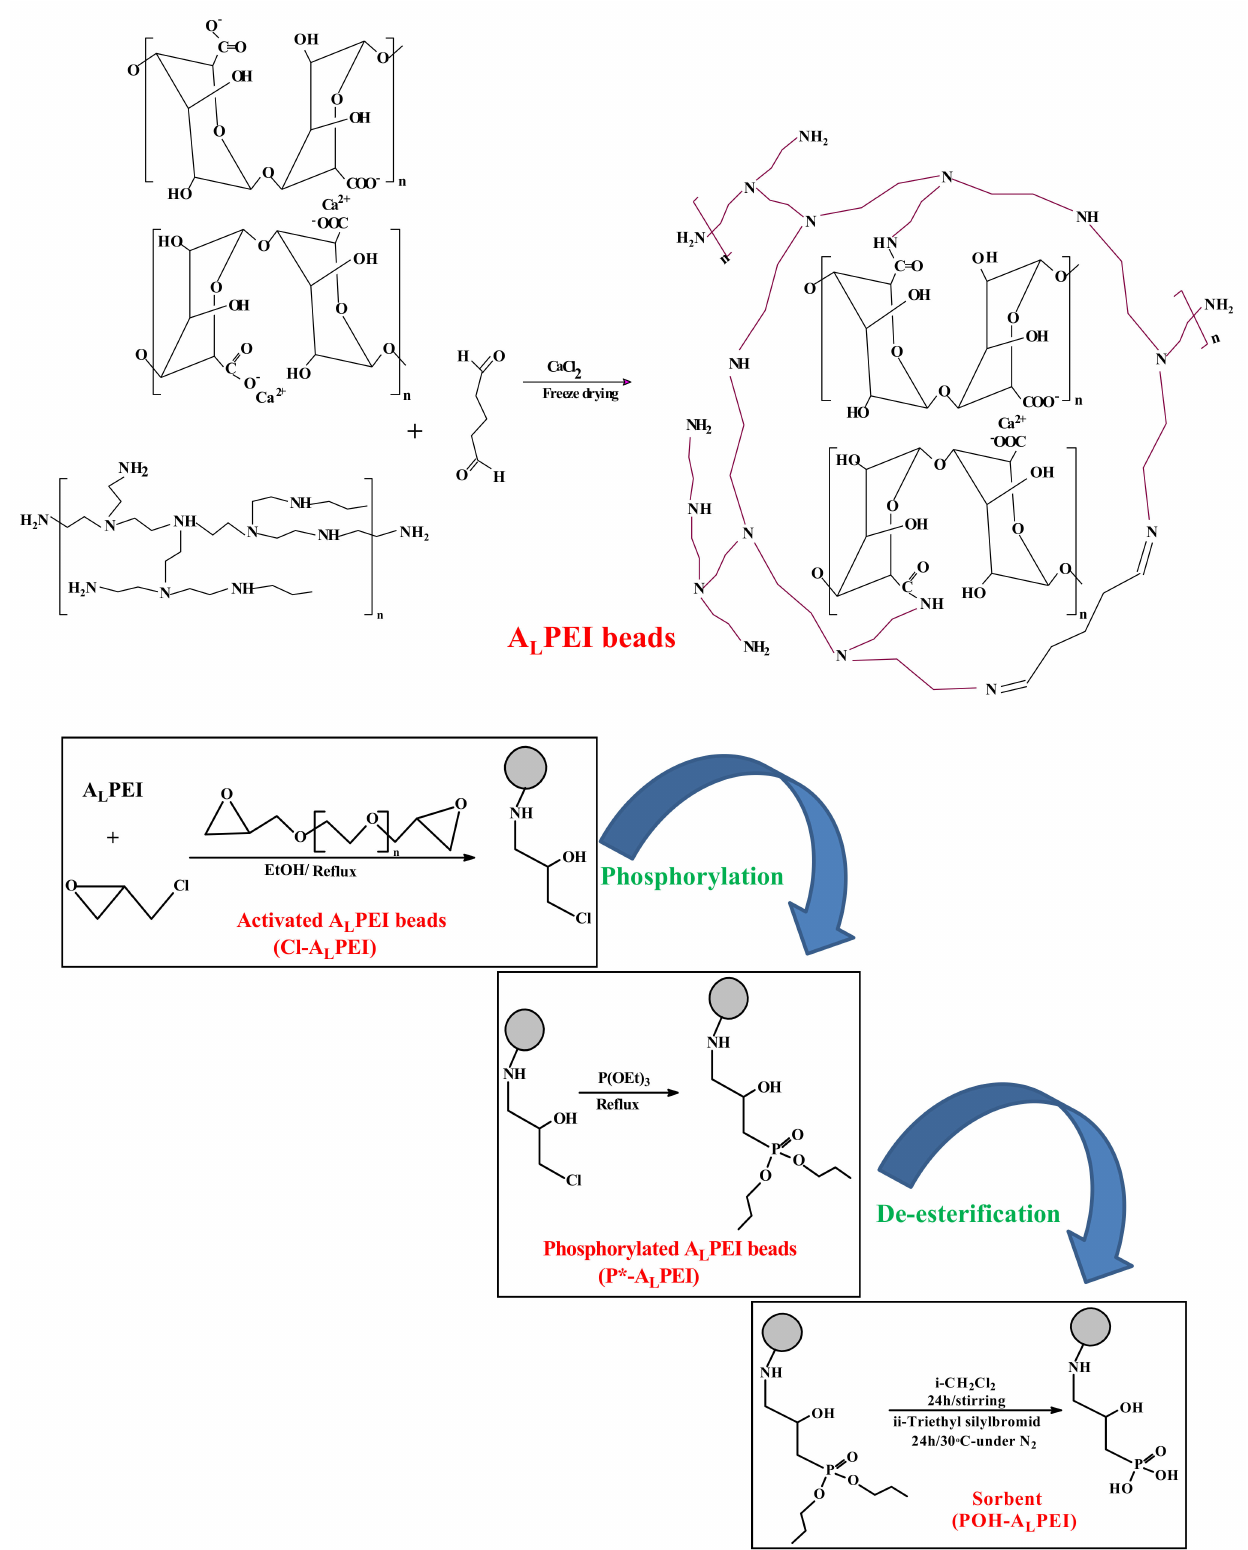
Scheme 1. Procedure for the synthesis of POH-A L PEI